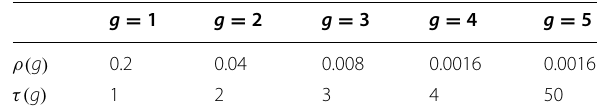
Table 2 Variable